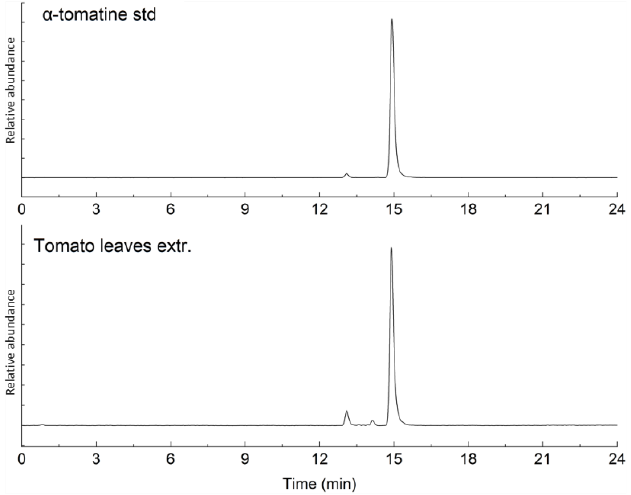
Figure 2. Stacked mass chromatograms of α -tomatine standard and the tomato leaf extract. Table 1. The concentration of main components in the tomato and olive leaf extracts ( n = 9).